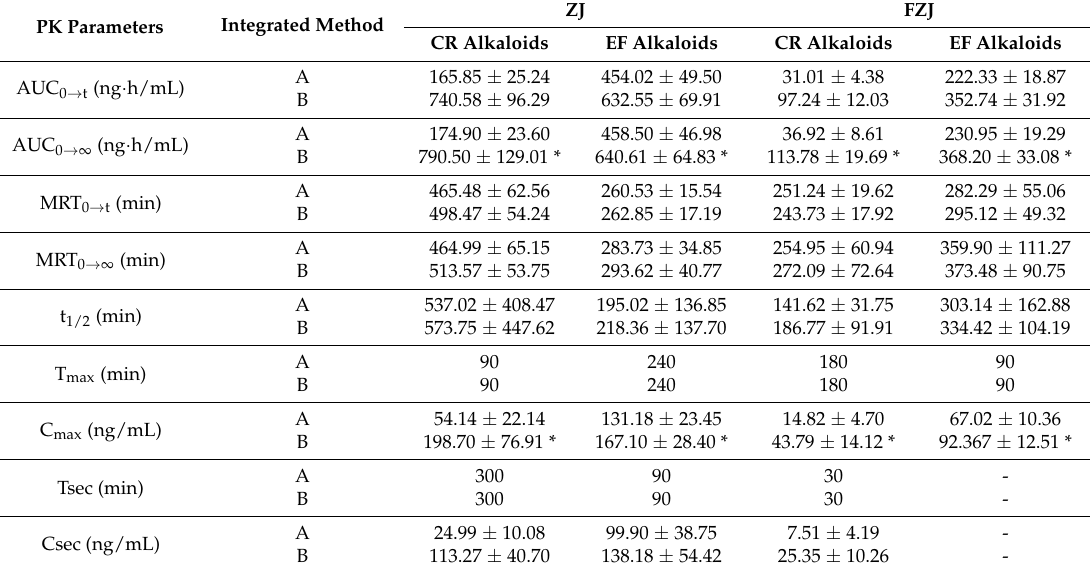
Table 4. Integrated PK parameters of the CR and EF alkaloids in rat plasma after oral administration of ZJ and FZJ extract (mean ± SD, n = 6).